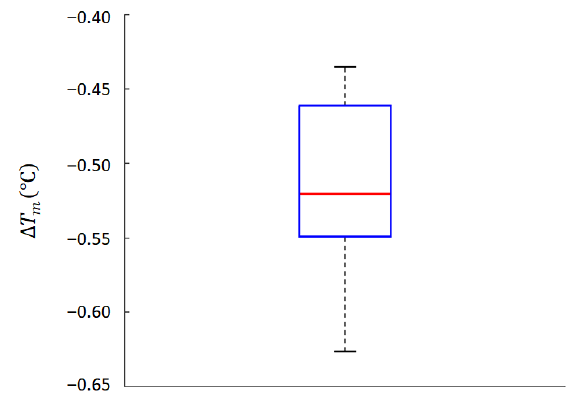
∆ T Figure 3. Box-whisker plot for ∆𝑇 𝑚 , calculated using various EBMs with parameters listed in Table 1. Figure 3. Box-whisker plot for m , calculated using various EBMs with parameters listed in Table